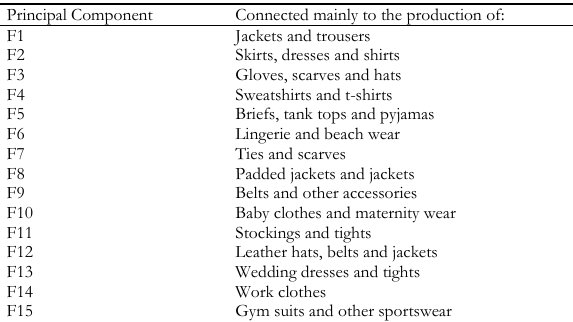
Description of the first 15 principal